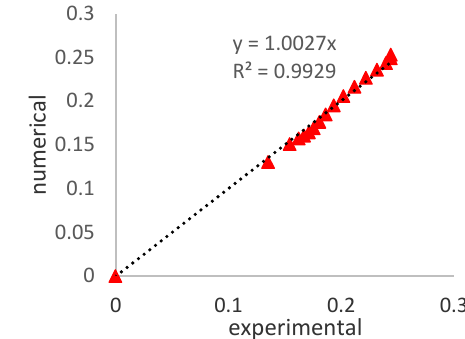
Fig.5. Comparison of the V